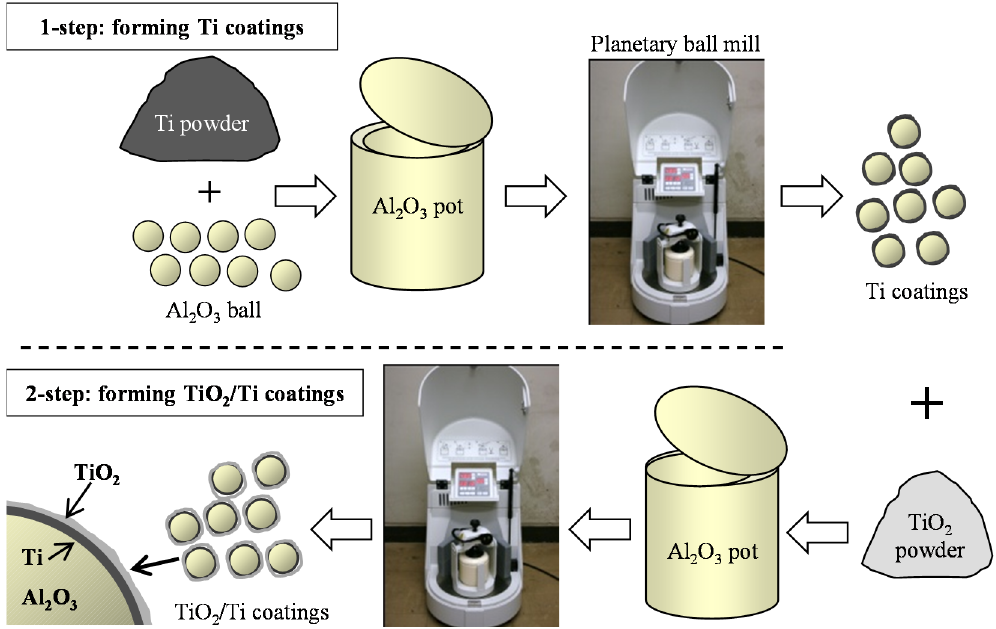
Figure 21. Schematic diagram of two-step